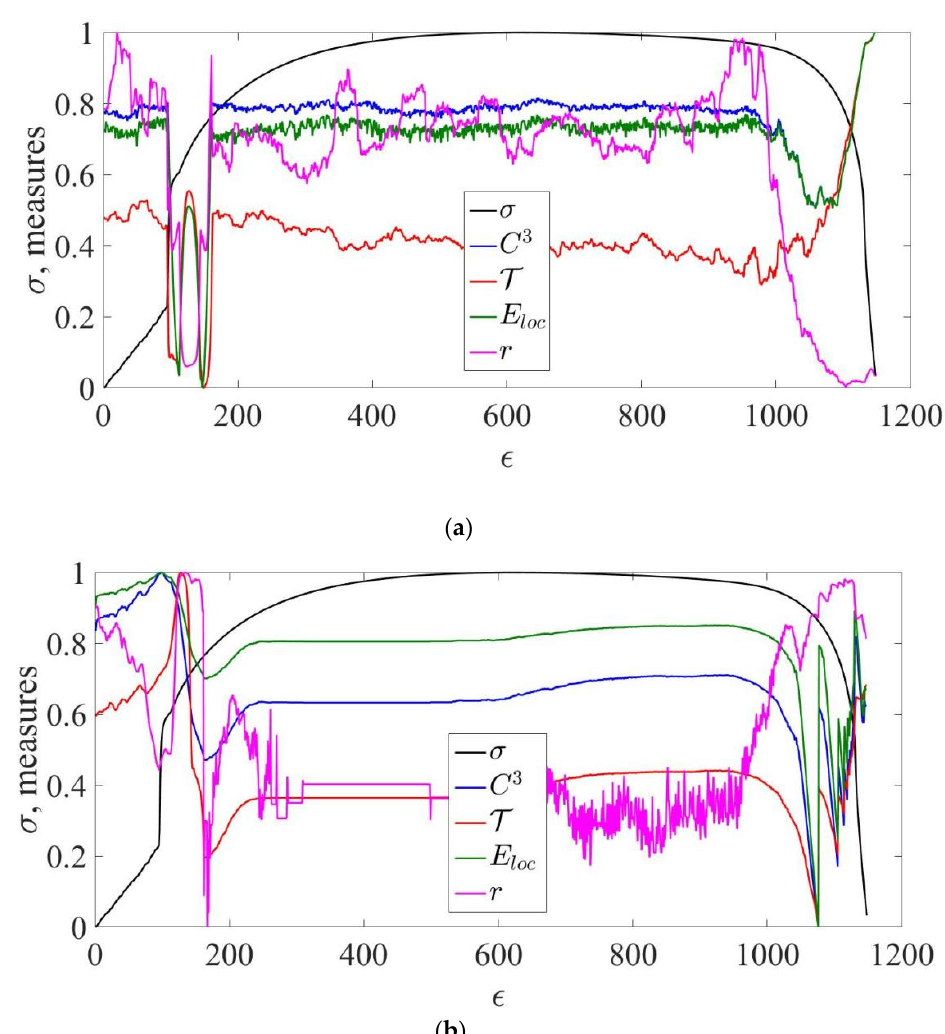
Figure 7. The dynamics of the clustering-based measures of complexity such as C 3 and T with local efficiency E loc and assortativity coefficient r based on the VG ( a ) and the RP ( b ) approaches for the stress–strain time series.